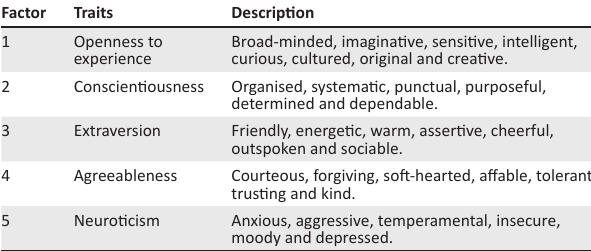
TABLE 1: The five-factor personality model. Factor